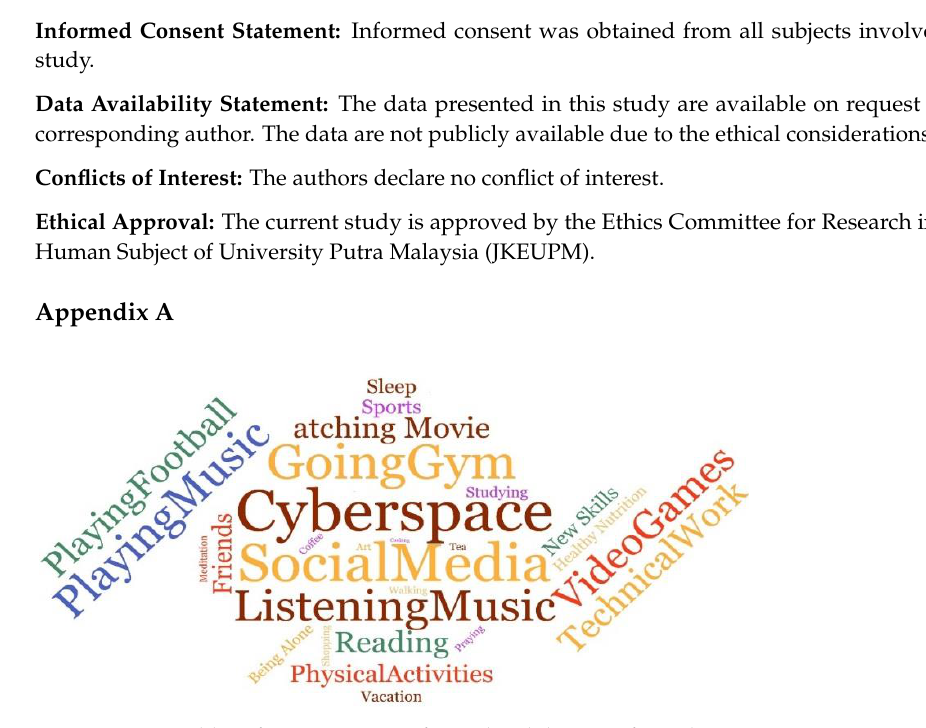
Figure A1. Suitable safe-care activities for male adolescents from their viewpoint.